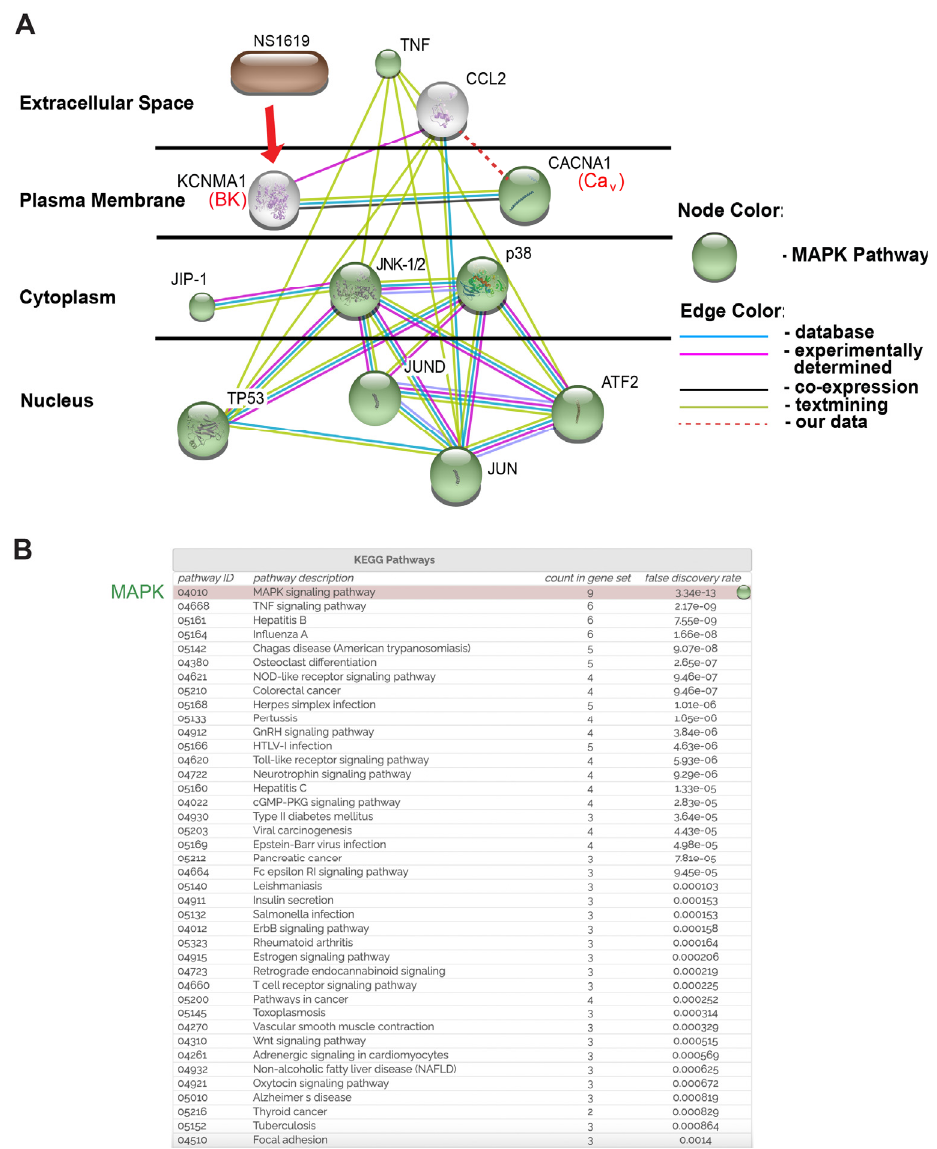
Figure 4. Chemical/drug-protein interaction analysis (STITCH): This putative model predicts that NS1619 reduces TNF- α -induced CCL-2 secretion through the inhibition of JNK-1/2, p38, and JUN activation. ( A ) CACNA1 (Ca V channels), KCNMA1 (BK channels), CCL-2, TNF- α , JNK-1/2, p38, and NS1619 were entered as query parameters along with the predicted five most likely interaction partners: JIP-1, TP53, JUN, JUND, AFT2. The confidence level was set as “high” (0.8 on a 0–1 scale). Proteins are allocated according to their cellular location. Proteins involved in the Ca 2+ -dependent MAPK pathway are indicated in green. All proteins in this figure are labeled with their gene names, as is conventional in the literature. The red dashed line depicts the association between Ca V channels and CCL-2 identified in this study. ( B ) KEGG pathway analysis of the STITCH model highlights the MAPK pathway as the top candidate pathway. “Count in gene set” is a parameter in gene enrichment analysis: a powerful analytical method for interpreting gene expression data. It ranks all genes in a data set, then calculates an enrichment score for each gene set (the higher the “count”, the more often members of that gene set occur at the top of the ranked data set).